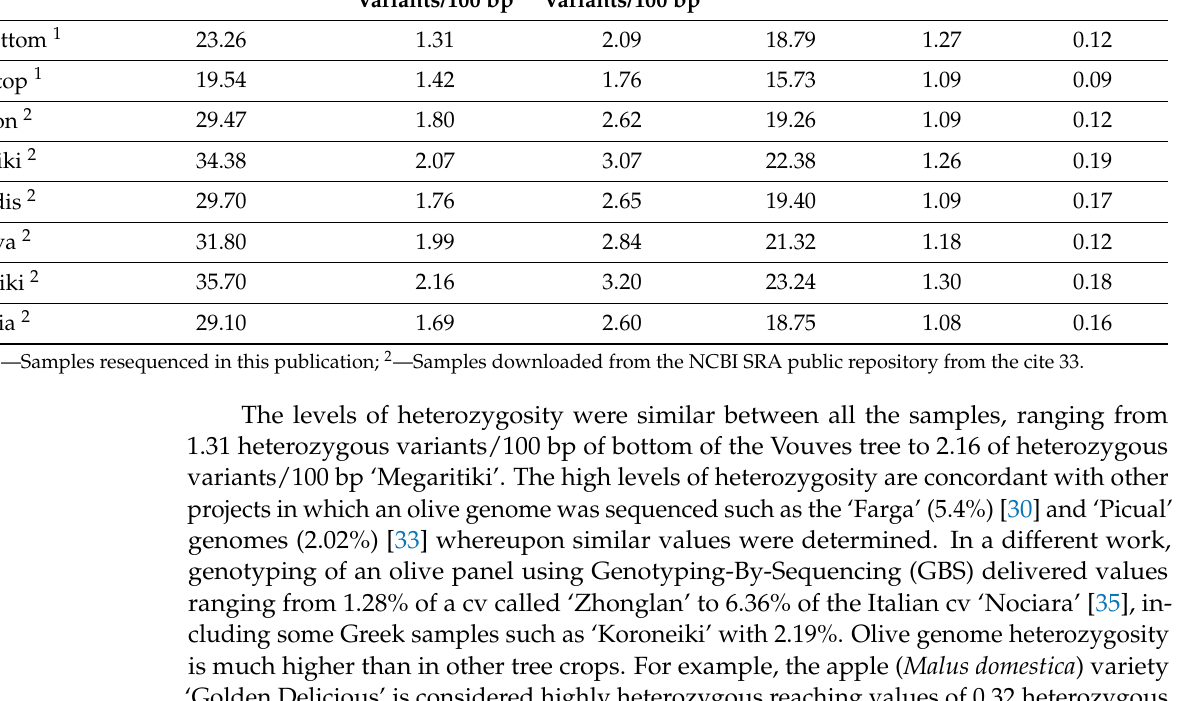
Table 1. Different type of variants determined following comparison of the two Vouves samples and six previously sequenced Greek cvs with the genome of Olea europaea var. sylvestris version Oe451. Sample Total Variants